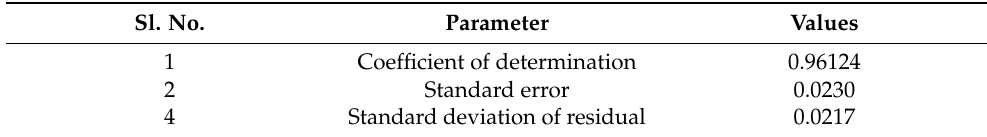
Table 6. Output parameter of the developed regression model. Sl. No.